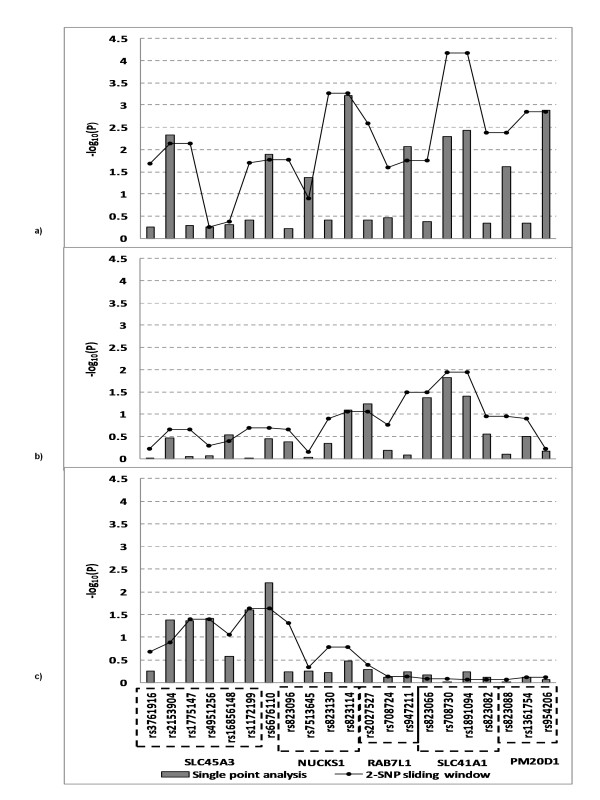
Single point and haplotype analysis of PARK16 in Ashkenazi Jewish a), NINDS b) and CIDR/Pankratz et al 2009 c) datasets. 2-SNP sliding window, the strongest p-value was present from the exhaustive search.